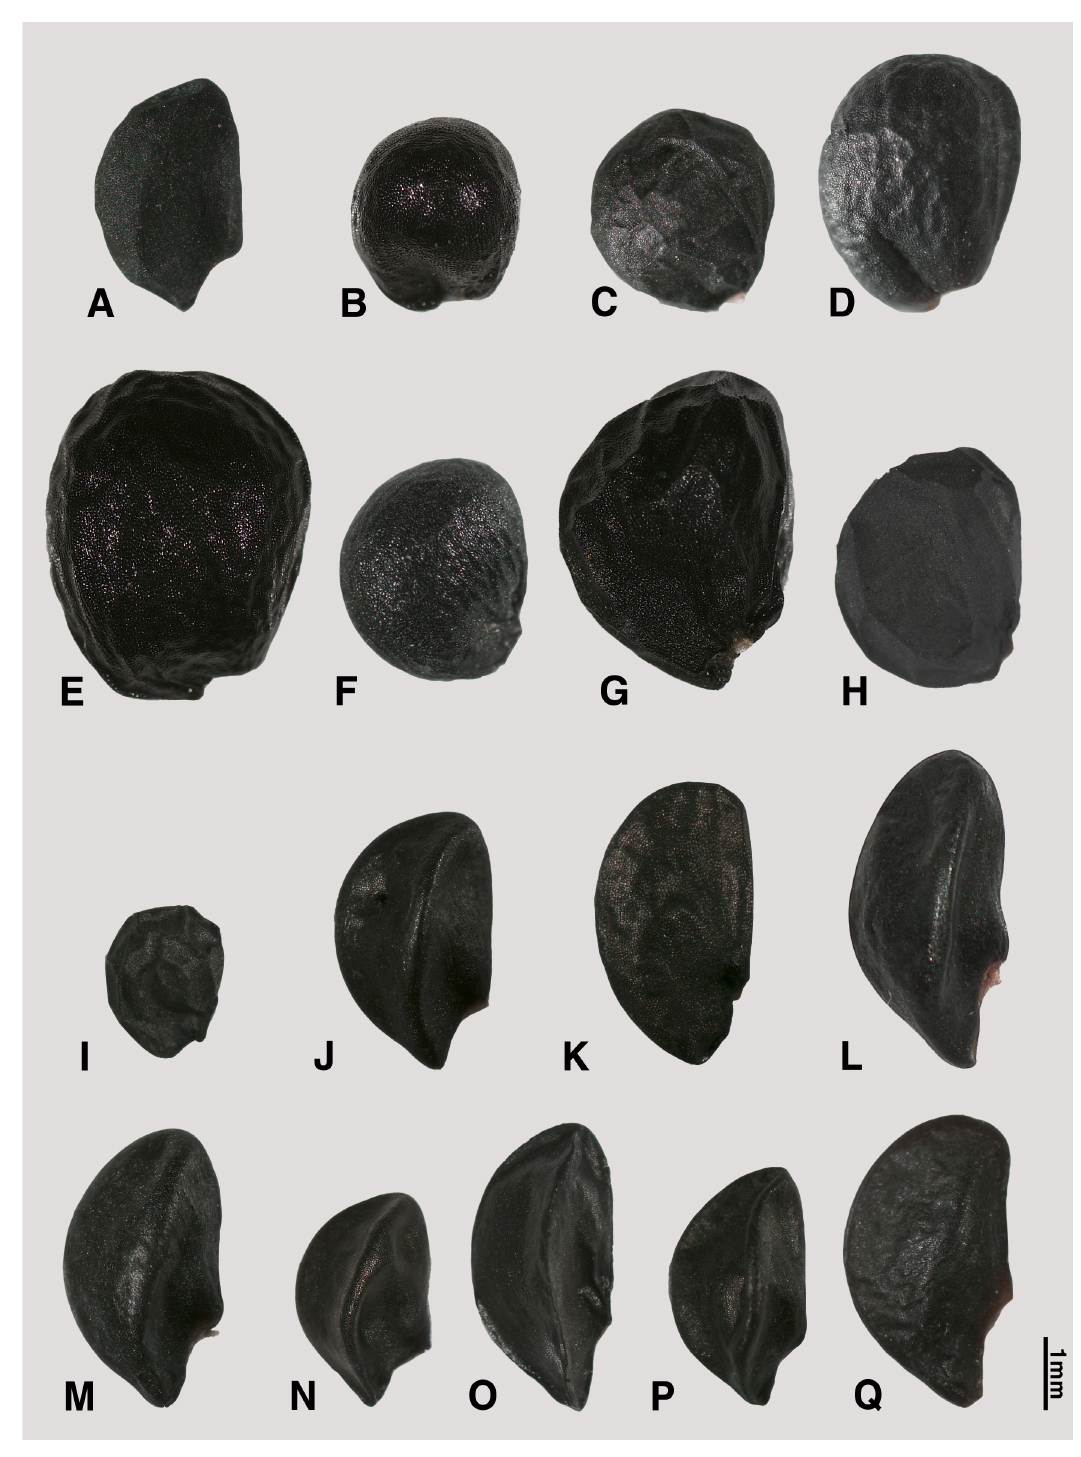
Figure 2. Various shapes of seed in Allium . A – I subg. Melanocrommyum : A A. saposhnikovii (sect. Acmopetala ); B A. alexeianum ; C A. caspium ; D A. protensum (sect. Kaloprason ); E A. karataviense (sect. Miniprason ); F A. altissimum ; G A. stipitatum (sect. Procerallium ); H A. taeniopetalum (sect. Stellate ); I A. viridiflorum (sect. Verticillata ); J – Q subg. Polyprason : J A. carolinianum ; K A. hymenorrhizum ; L A. platyspathum subsp. amblyophyllum ; M A. platyspathum ; N A. korolkowii (sect. Falcatifolia ); O A. obliquum ; P A. petraeum ; Q A. tianschanicum (sect. Oreiprason ).